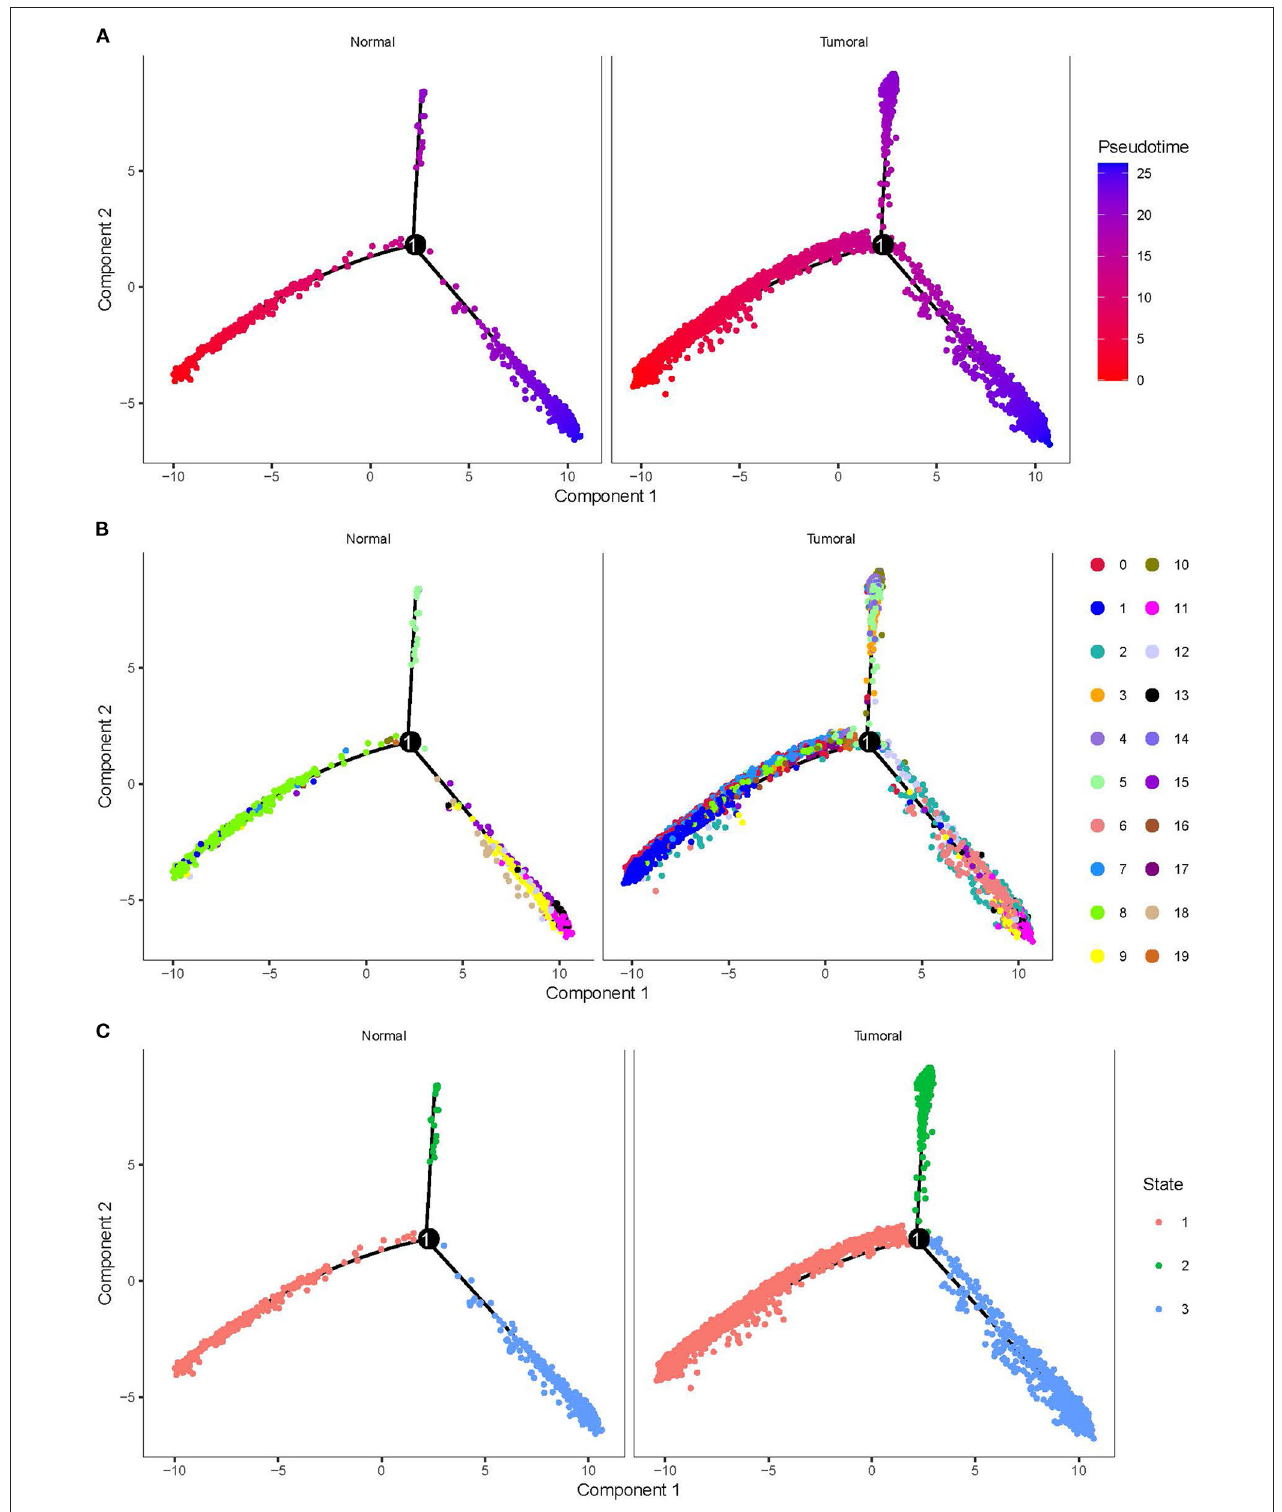
FIGURE 4 | Cell trajectory of 20 subgroups grouped by normal and tumoral. (A) Pseudotime of different subgroups. Colors from red to blue indicates pseudotime from early to late. (B) The location of 20 subgroups in the trajectory. (C) Three states with different colors defined by three branches.